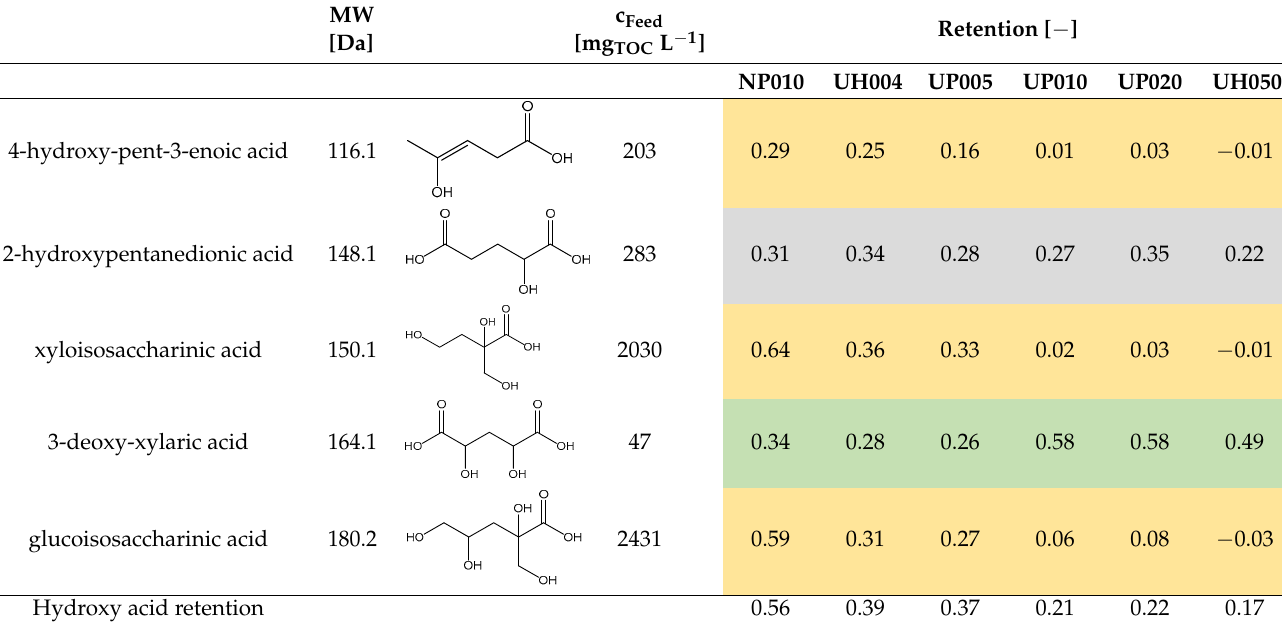
Figure 3. Retention of groups of hydroxy acids clustered based on their chain length.